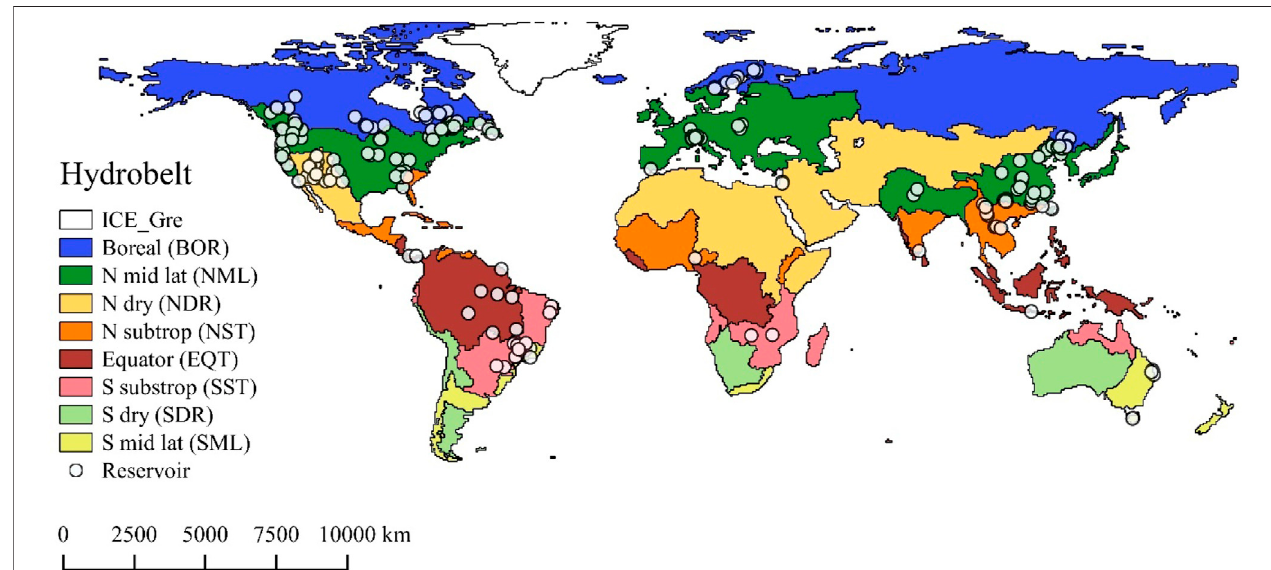
FIGURE1| Distributionofreservoirsanalyzed for GHGemissions and related parameters.The hydrobelt classi fi cation was referenced from Meybecket al. (2013).